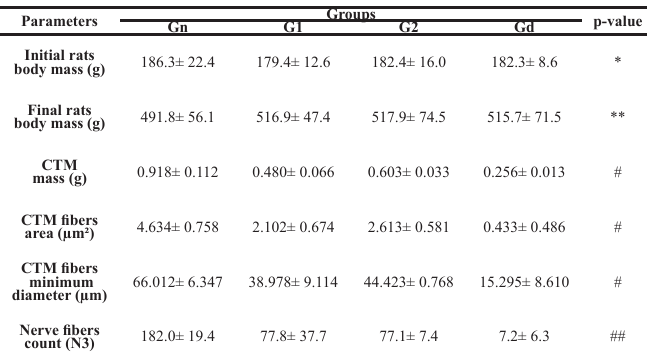
TABLE 1 – Comparative analysis between all groups and between groups